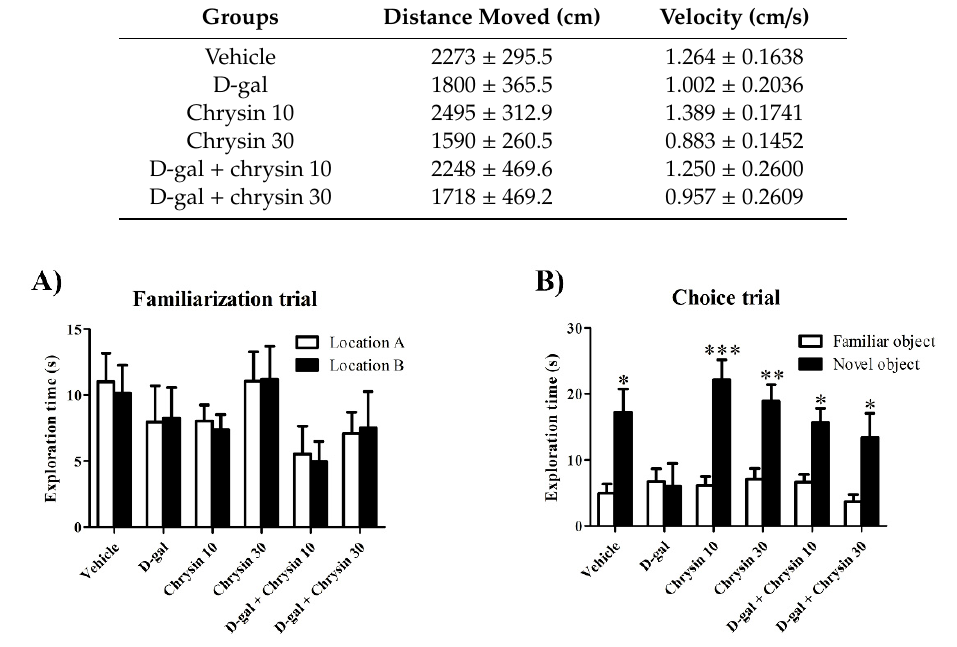
Figure 3. The exploration time (mean ± SEM) of each object in the NOR test after treatment. In the familiarization trial, there was no significant difference between objects A and B in terms of exploration time in any of the groups ( p > 0.05, A ). In the choice trial, the vehicle, chrysin 10, chrysin 30, and D-gal + chrysin groups explored the novel object significantly longer than the familiar object (* p < 0.05, ** p < 0.01, *** p < 0.001, B ), but those in the D-gal group did not ( p > 0.05, B ).